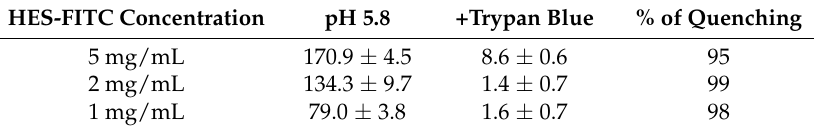
Figure 1. Association of HES to the outer plasma membrane of neutrophils. ( A ) Neutrophils were treated with different concentrations of FITC-labeled HES, washed and the resulting fluorescence read with a microplate fluorimeter. There was an increase in fluorescence with increasing concentrations of HES-FITC ( n = 3). ( B ) After the treatment with HES-FITC and washing steps, neutrophils were incubated with PBS or NH 4 Cl in order to rule out a possible internalization of HES into phagolysosomes. No significant difference in the fluorescence of the cells treated with NH 4 Cl compared to the control was observed, suggesting that HES was bound to the outer plasma membrane and not internalized ( n = 3). The data are presented as mean ± SD ** p < 0.01. Table 1. Fluorescence intensities of HES-FITC treated cells measured after quenching of the extracellular signal with trypan blue.